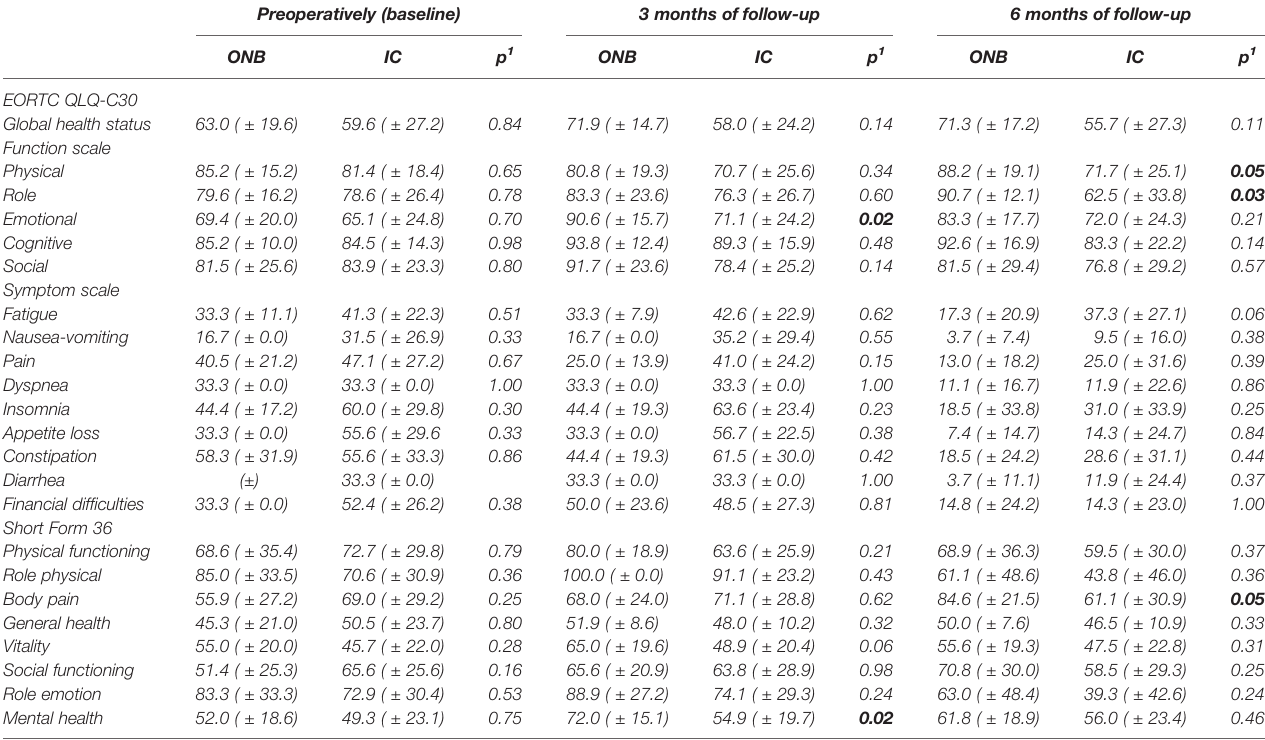
Bold values are statistically signi fi